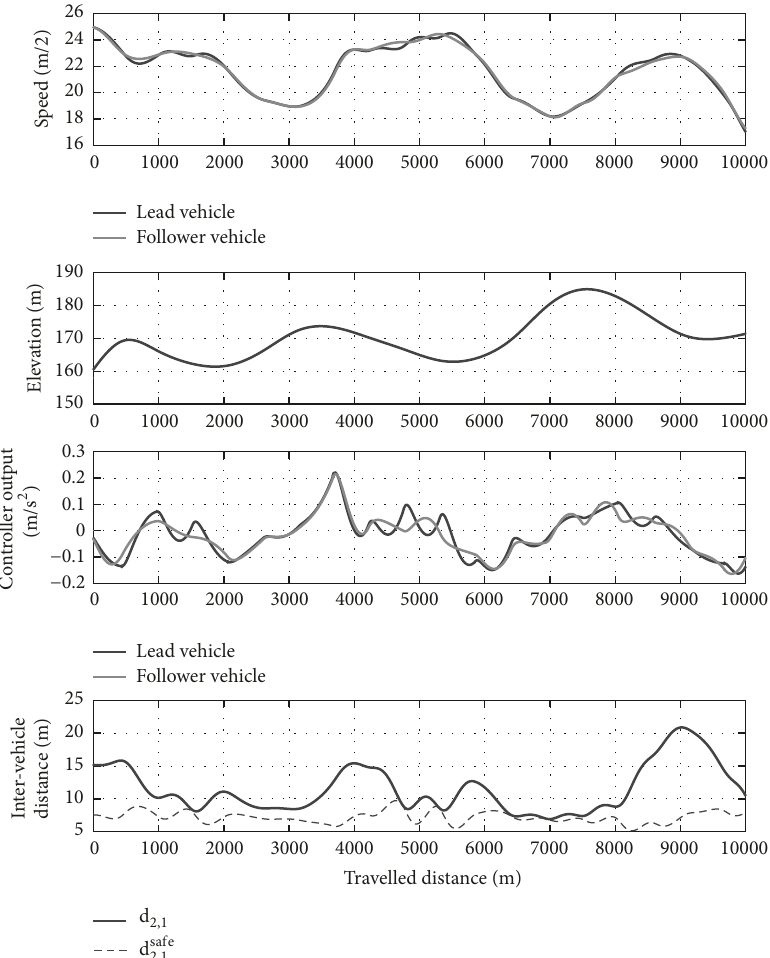
Figure 4: Top panel: one of the ten optimized sets of speed profiles for a heterogeneous platoon of two HDVs. Second panel: the road profile. Third panel: the HDV’s controller output 𝑢 along the road, normalized by the total inertial mass 𝑚(𝐺) . Bottom panel: the intervehicledistance 𝑑 𝑑 safe 𝑖,𝑖−1 , (solid line) and the corresponding safe distance, 𝑖,𝑖−1 , and (dashed line) computed using